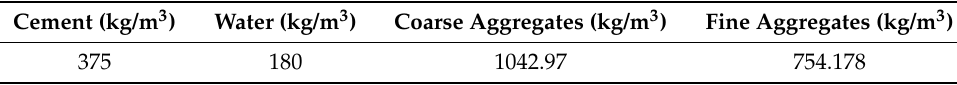
Table 2. Concrete mix design.